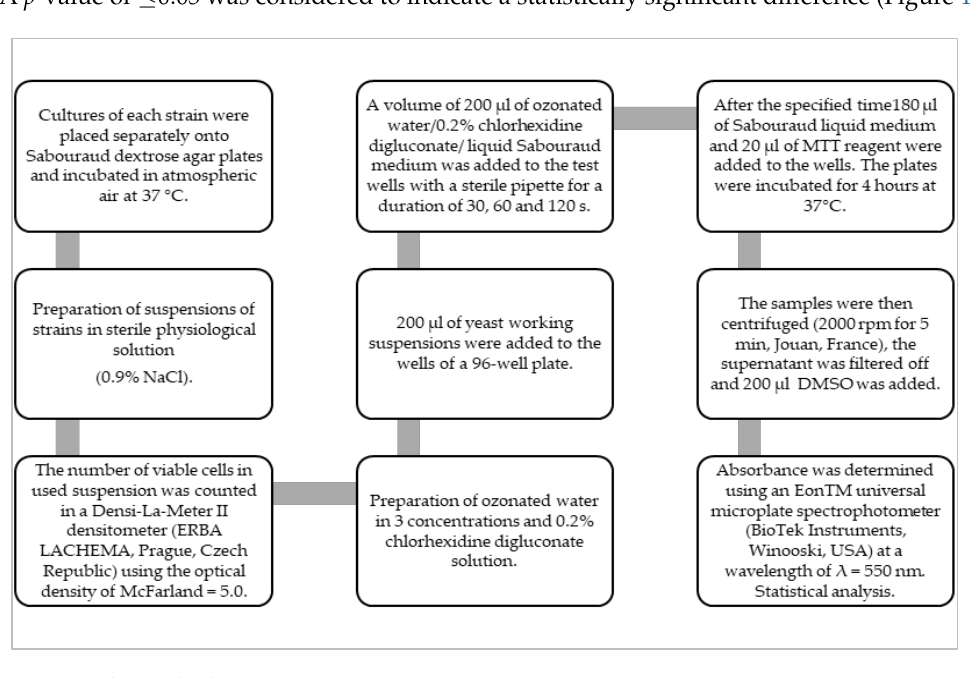
Figure 2. Viability of cells of Candida albicans ATCC 10,231 to ozonated water and chlorhexidine after three exposure times. n= 8 where n is the number of independent replications.